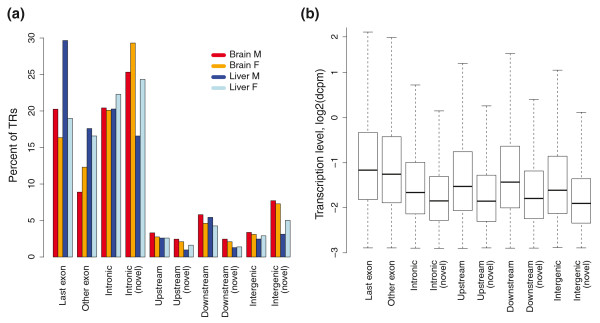
Genomic distribution and expression level of transcribed regions. (a) A histogram of the percentage of TRs in different genomic locations. The results are grouped into different genomic locations along the x-axis and the y-axis represents the percentage of TRs in each genomic location. Each tissue is plotted separately in a different color. (b) A boxplot of the transcription levels (measured in dcpm) for TRs in different genomic locations. The x-axis shows different genomic locations and expression values are on the y-axis. In this figure, all samples are pooled together.